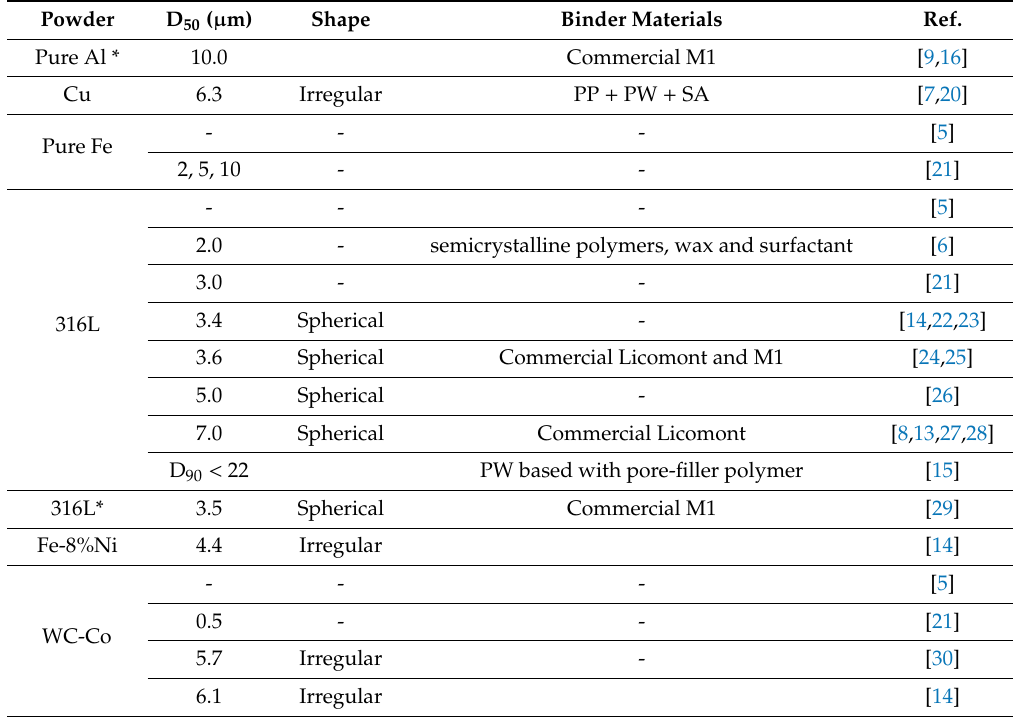
Table 1. Composition and characteristics of the powders and binders used for powder hot embossing.